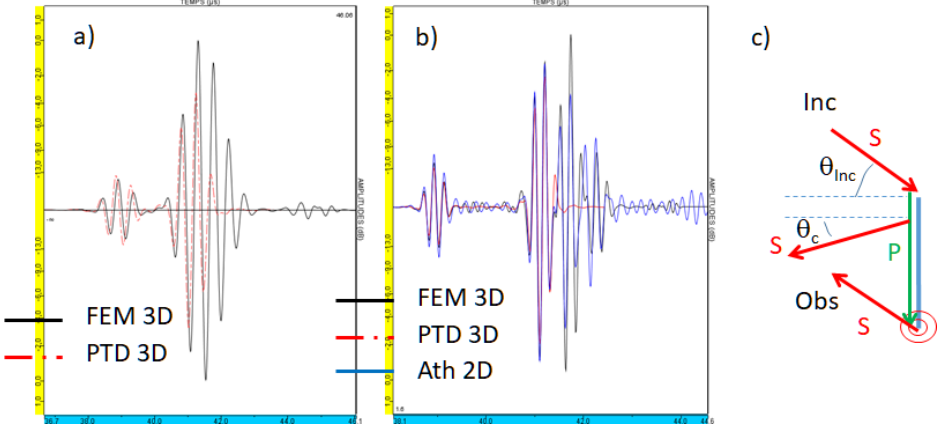
Figure 8. ( a ) Inspection of rectangular crack using SV45 waves in Pulse Echo mode at 2.25 MHz (circular planar probe of 6.35 mm diameter), ( b ) of 5 mm height and varying extension and ( c ) of a 34 mm extension and varying height.